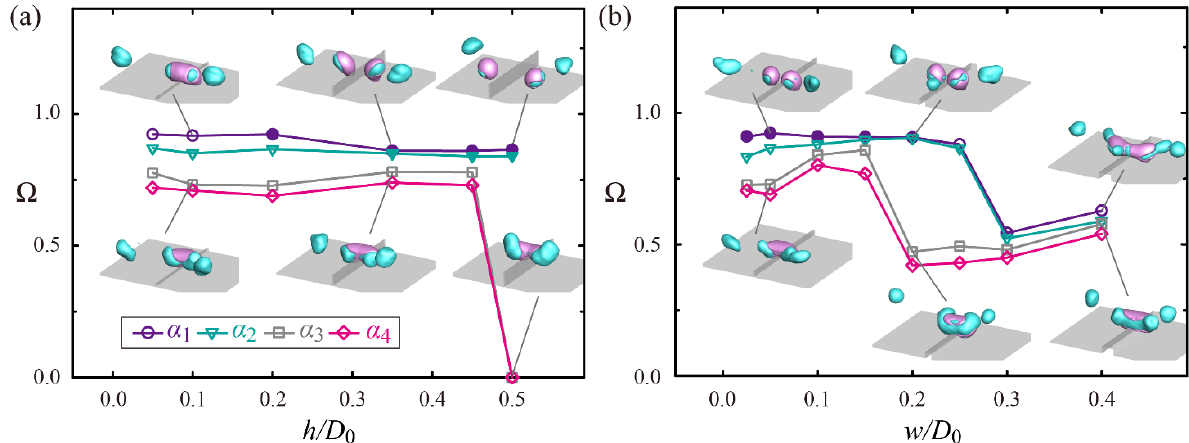
Figure 7. Dependency of Ω on ( a ) height and ( b ) width of the ridge. Filled and open symbols represent the fragmentation/non-fragmentation situations for G-part, respectively. Snapshots of the insets are obtained from drop impact on macroridges with ( a ) h / D 0 = 0.1, 0.35, and 0.5 and ( b ) w / D 0 = 0.05, 0.2, and 0.4 for two viscosity ratios of α 1 and α 3 . The Weber number in ( a , b ) corresponds to We w = 61.